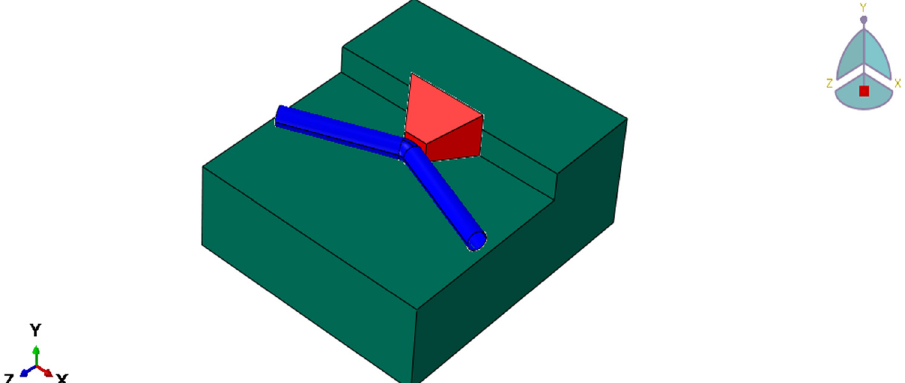
Figure 12: General view of Case 3.